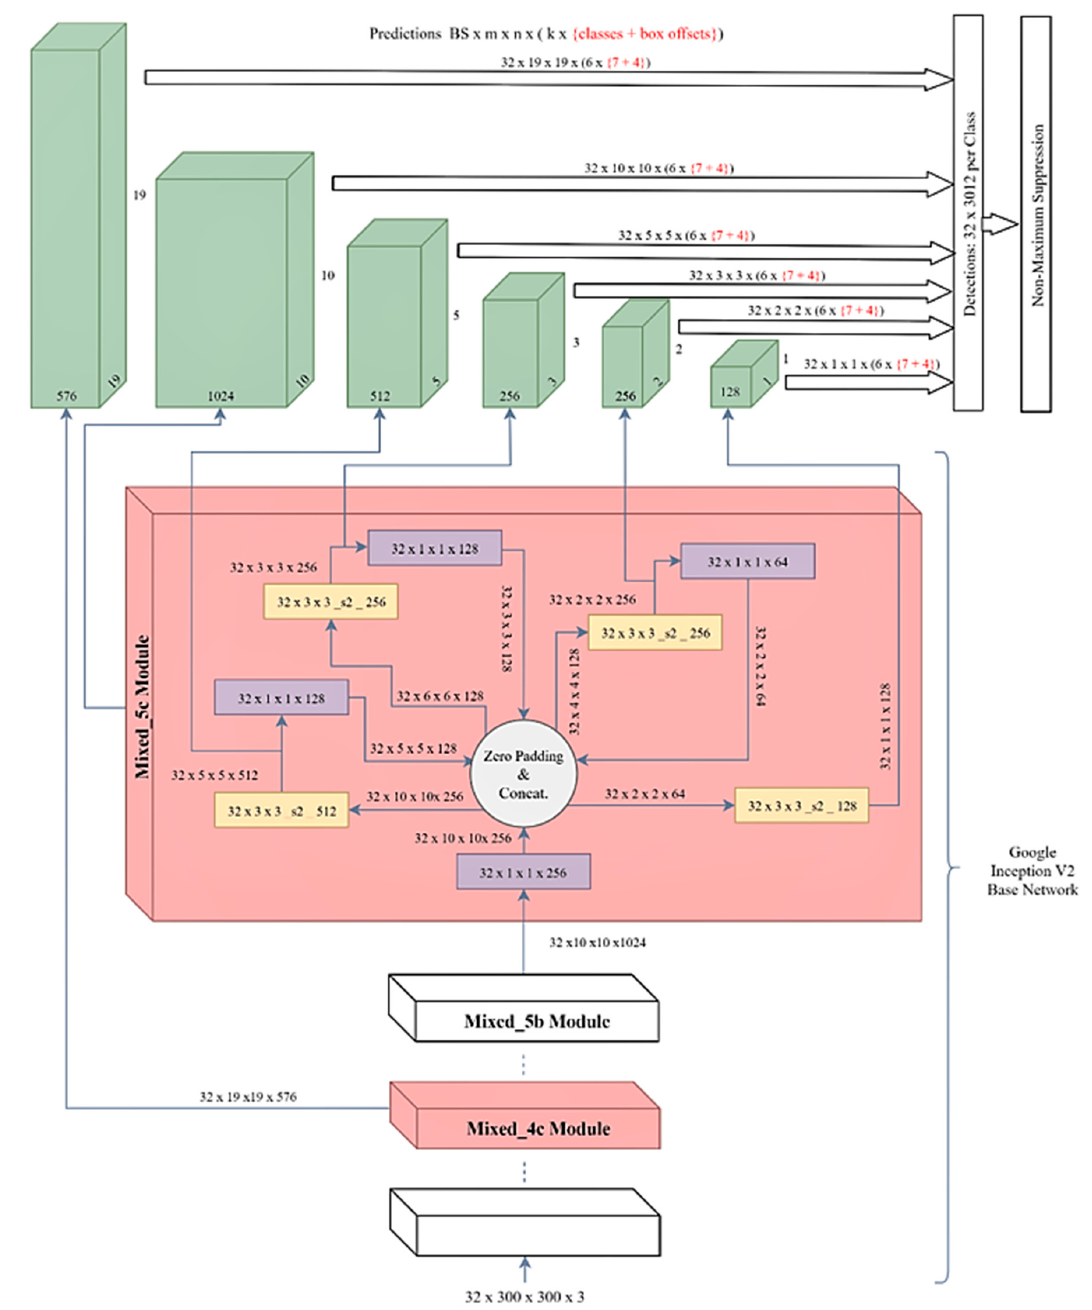
Figure 4. SSD architecture that uses Inception V2 as a base network with 32 as the batch size at